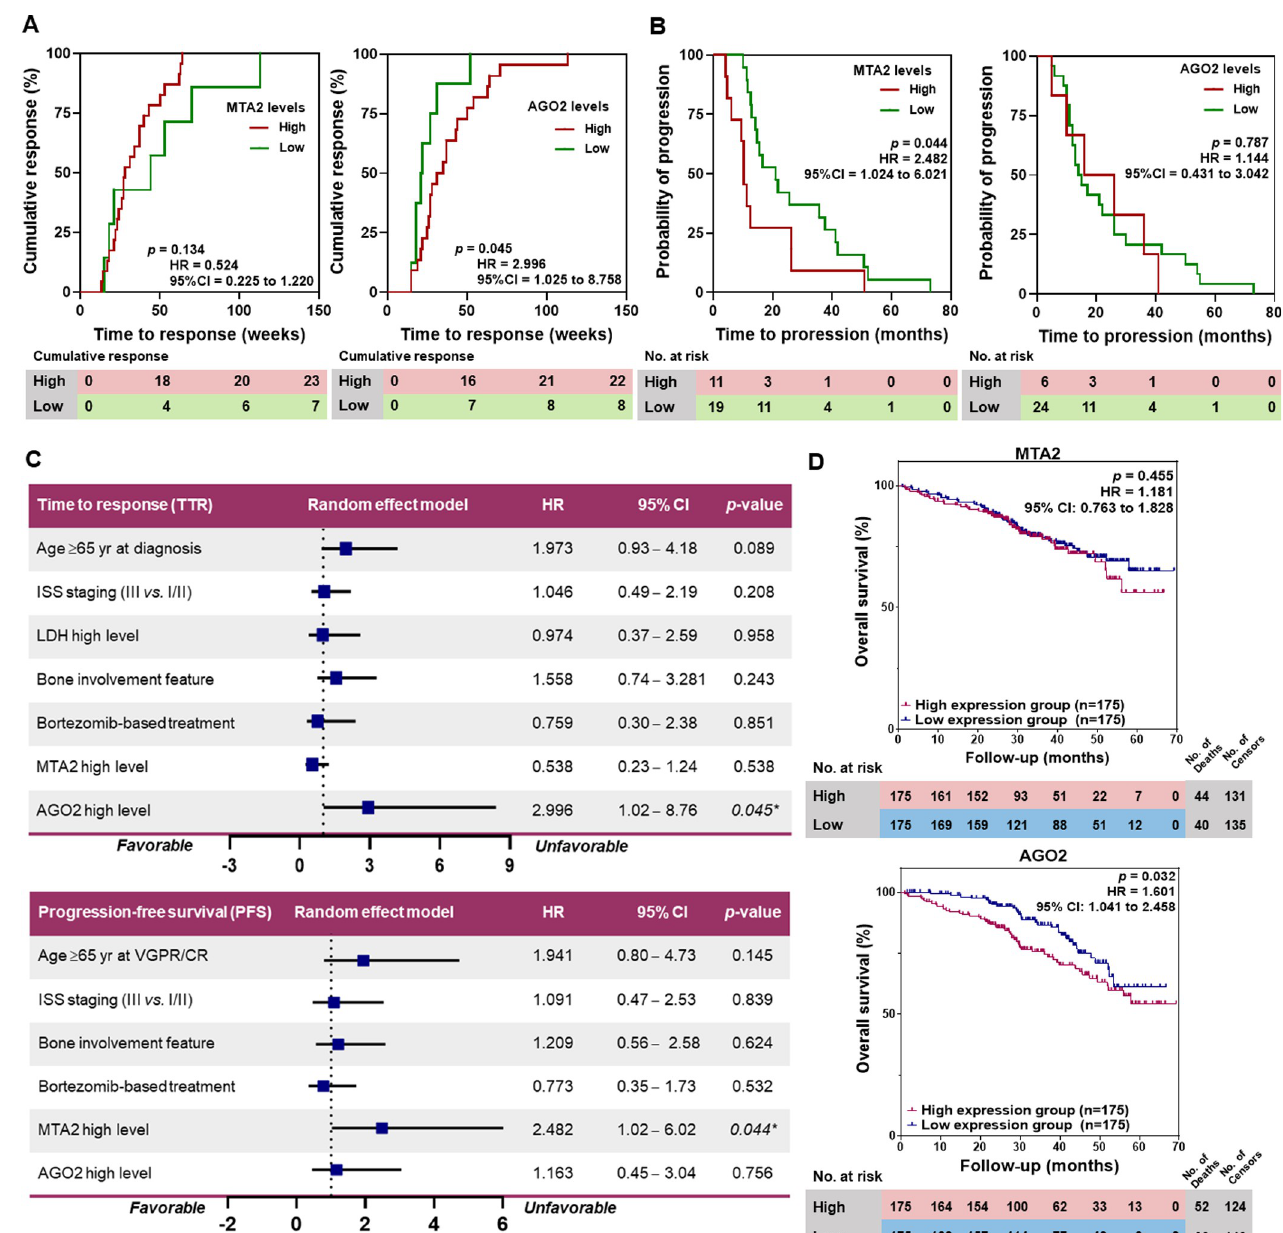
Fig 6. Impact of MTA2 and AGO2 levels on patient outcomes. (A) Kaplan-Meier plots demonstrated the TTR of patients according to MTA2 and AGO2 levels. (B) Kaplan-Meier plots demonstrated the PFS of patients according to MTA2 and AGO2 levels. (C) Forest plots of univariate Cox regression models with probabilities for each factor associated with TTR and PFS of MM based on clinical variables. (D) Kaplan-Meier analysis of patient outcome data from the GSE2658 [28] data set (n = 350) demonstrated the OS of patients with MM expressing higher levels of MTA2 and AGO2 compared with those with lower expression levels based on the median expression of the